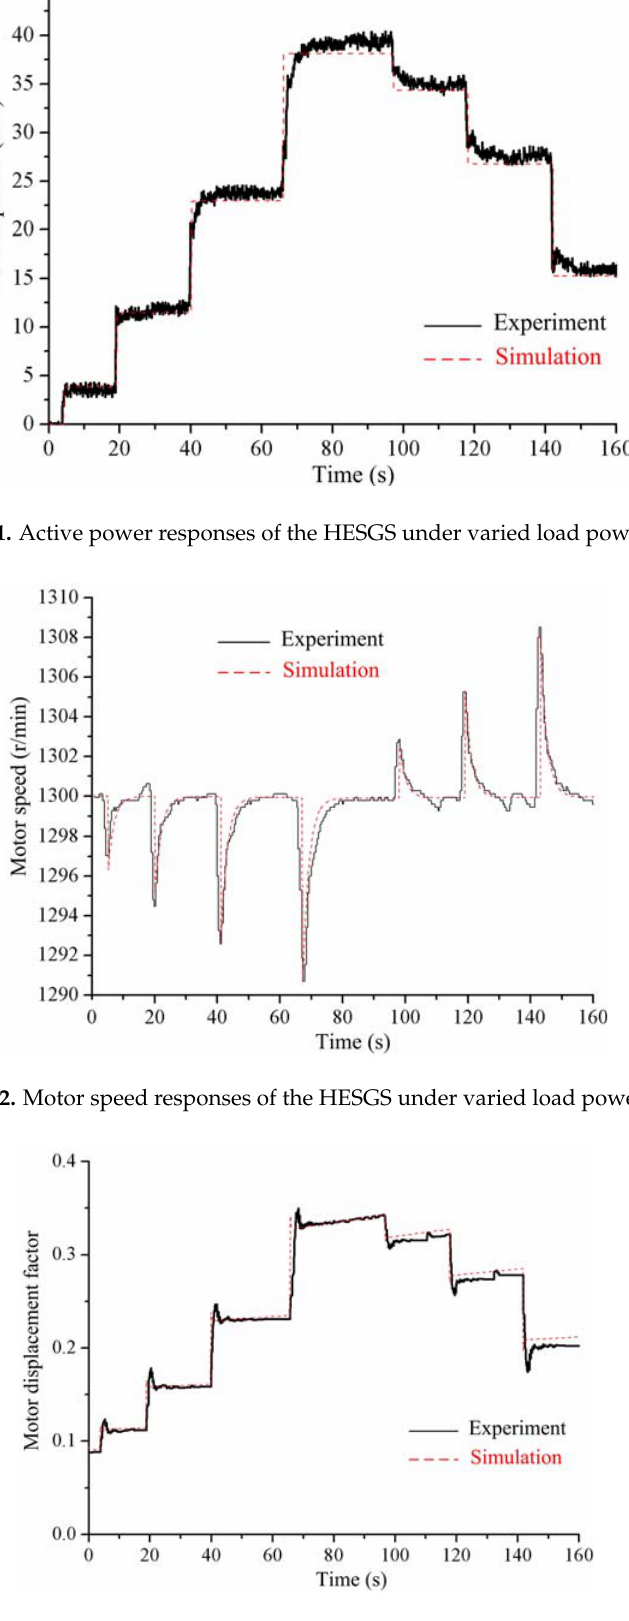
Figure 13. Motor displacement responses of the HESGS under varied load power step.